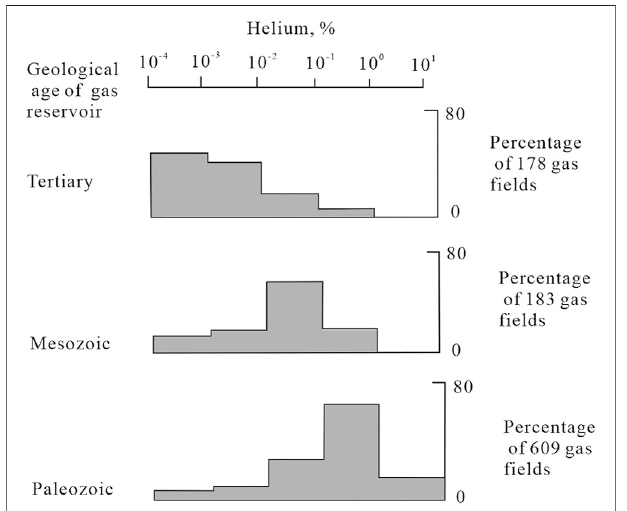
FIGURE 3 | Helium contents in gas fi elds formed in different geological eras around the world.